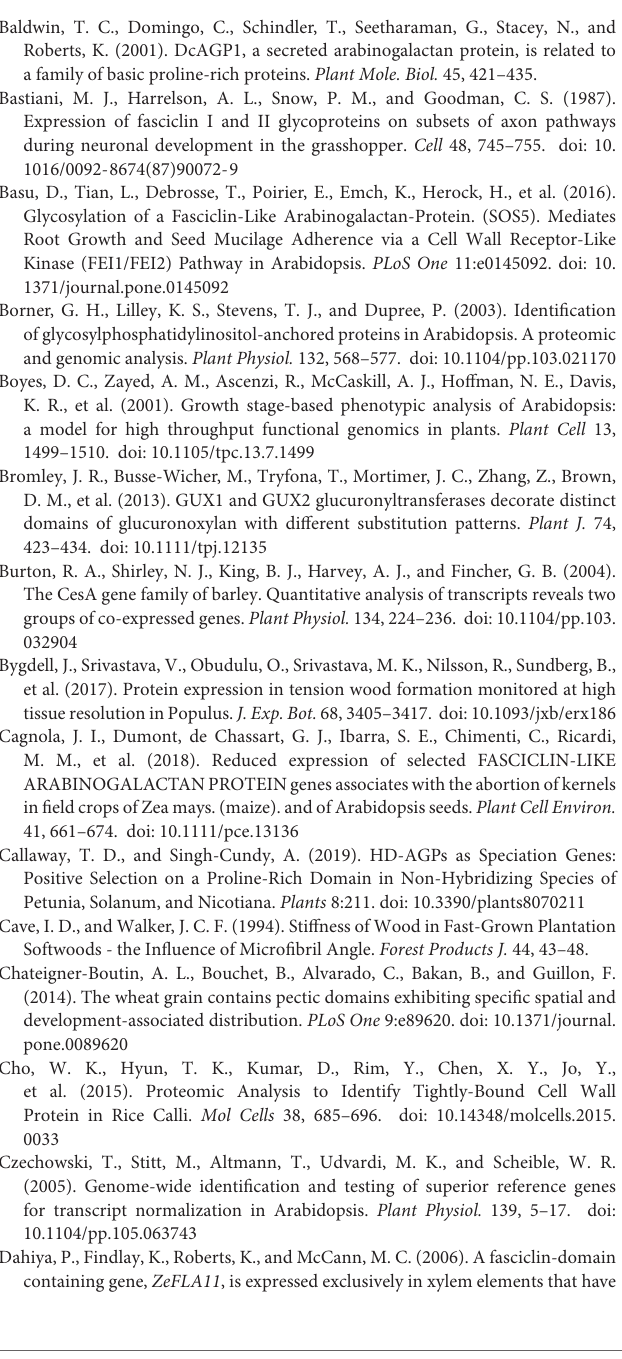
Supplementary Table 1 | Analysis of selected growth stages of long day grown wild-type (WT) and fla16 plants. Supplementary Table 2 | Polysaccharide composition from stems of fla16 and WT deduced from linkage analysis. Supplementary Table 3 | Measurement of stem biomechanical properties and cellulose content of WT and fla16 stems at maturity. Supplementary Table 4 | Primers for Q-PCR and cloning. Data File 1 | Sequences, alignments and phylogenies included in